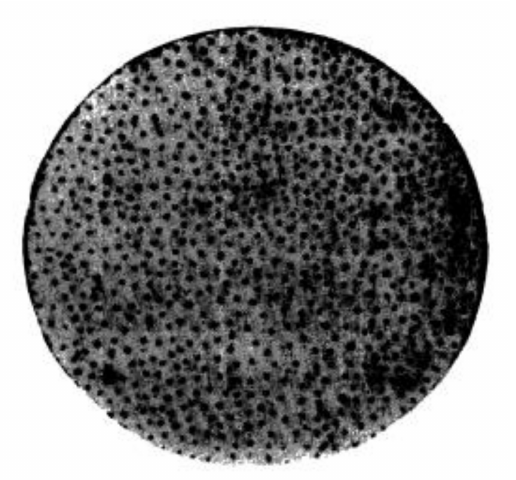
Figure 3. Photo [59] of the dense cylindrical domains in a gap that is filled with ferrofluid. The field is perpendicular to the figure plane. Published with permission of the American Physical Society (license RNP / 20 / AUG /